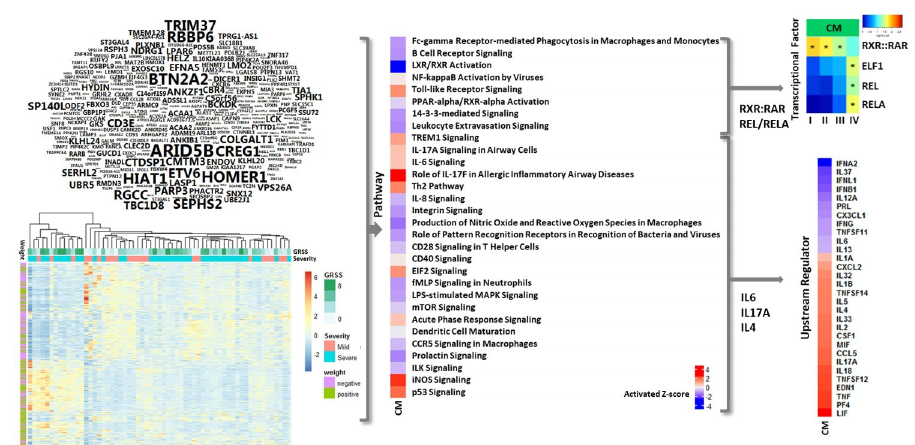
Fig 5. Nasal Epithelial gene weights, expression, pathways, transcriptional factors and upstream regulators associated with clinical severity in integration models. Shown are Integration model of CD4, nasal epithelial cells and microbiota (CM). Weights generated by integration models are shown in world-clouds. The size of word represents the absolute value of gene weight. A M1 word-cloud consists of genes with absolute weight greater than 0.0003. Gene expression are normalized expression levels for the 993 genes selected by univariate analysis; rows represent genes and columns represent samples. Red indicates higher expression, blue indicates low/no expression, green indicates Global RSV Severity Score (GRSS), soft orange indicates mild phenotype, lime green indicates severe phenotype, purple indicates negative weight and olive indicate positive weight. Transcriptional factors associated with severity in nasal epithelial cells were identified using a hypergeometric test. Four transcriptional factors are shown where p-values were less than 0.05. Ingenuity Pathway Analysis (IPA) was used to identify canonical pathways and upstream regulators represented by genes associated with severity in nasal epithelial cells. Thirty pathways and upstream regulators are shown where Fisher’s exact test p-values were less than 0.05. Red and blue indicate predicted increased or decreased pathway activation (activation z-score),